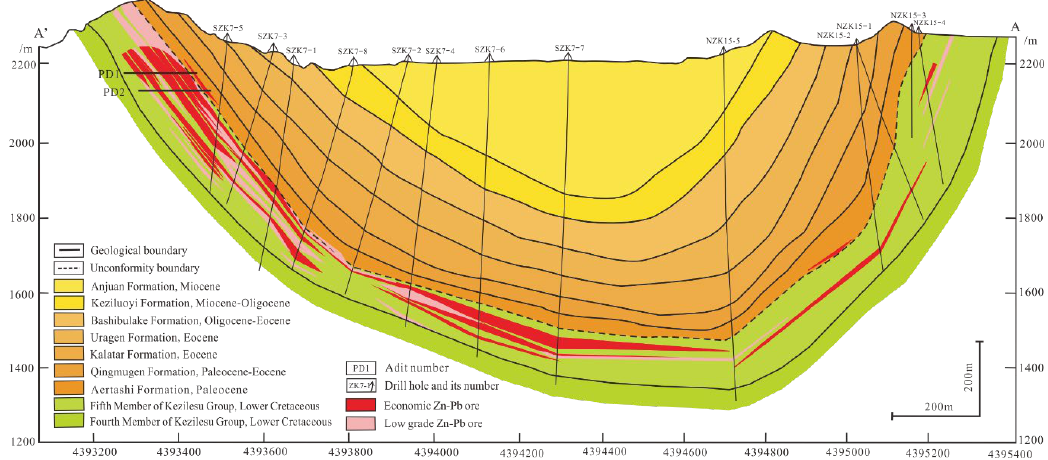
Figure 3. Profile A–A’ of the Uragen Zn–Pb deposit and the location is shown in Figure 2 (modified after [17]).